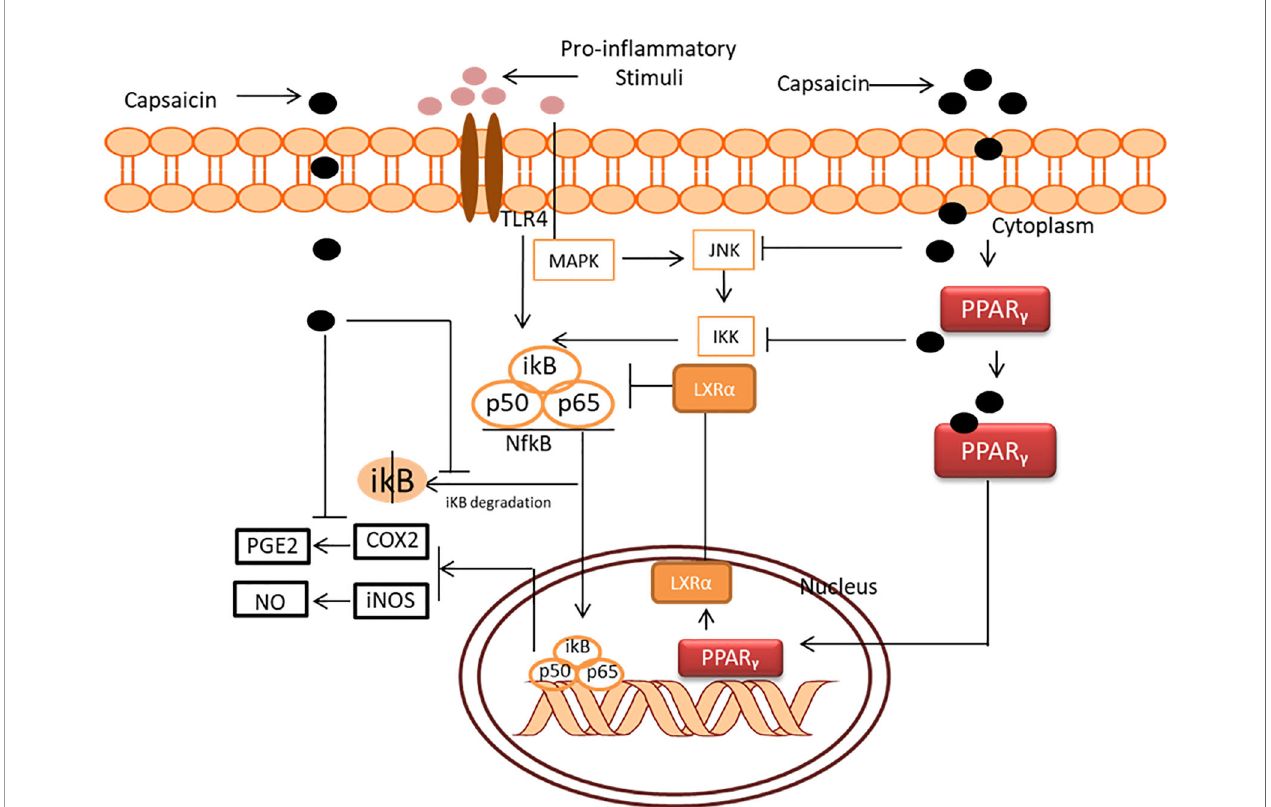
FIGURE 5 | Anti-in fl ammatory mechanism of